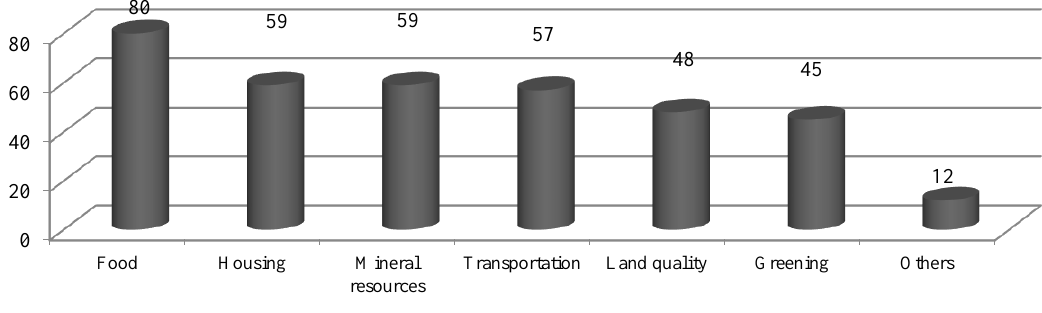
Figure 3. Factor scores of urban land ecological security